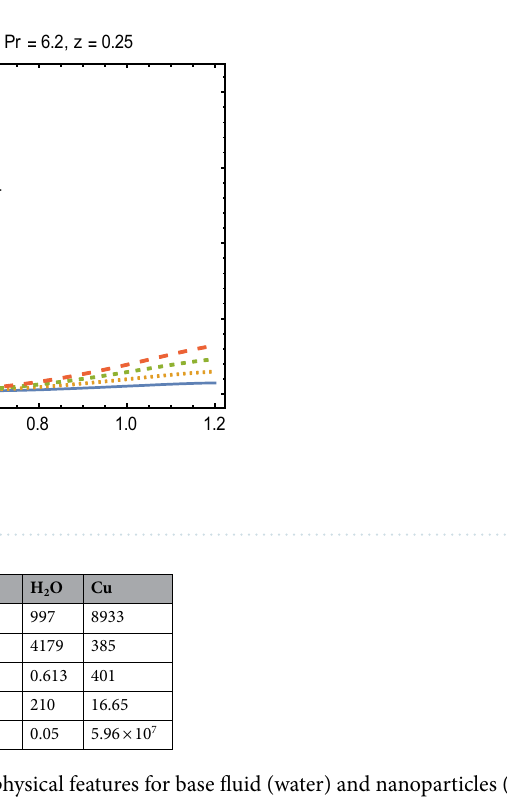
Table 1. Empirical values of thermophysical features for base fluid (water) and nanoparticles (copper) 23 .